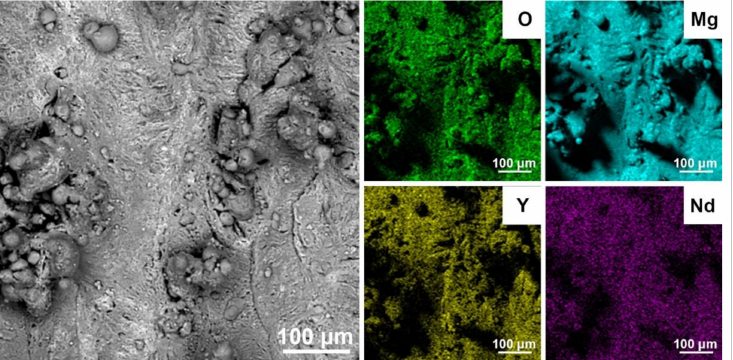
Figure 4. SEM image and EDS maps of elements distribution on the surface of 3D-printed material.